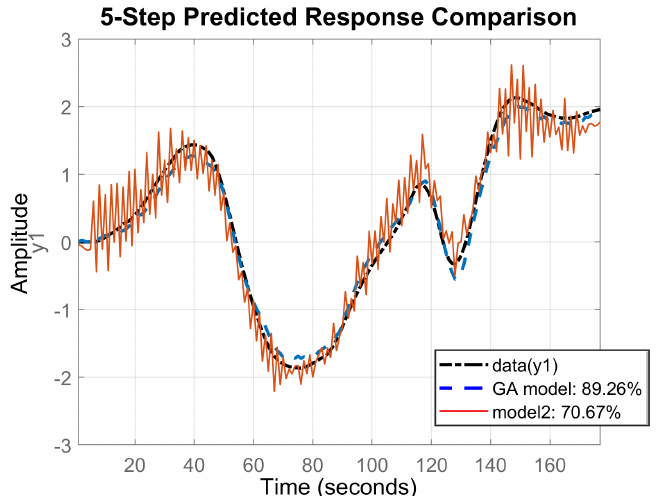
Figure 8. Regularized GA model and conventional model 5-step ahead prediction comparison based on real-time lake validation